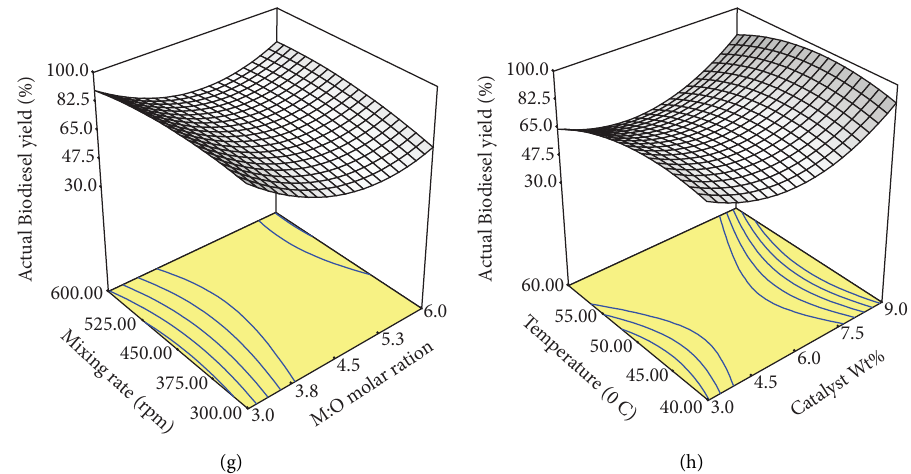
Figure 8: Te 2D contour and 3D RSM plots representing the interactive efects of the studied independent parameters on the trans- esterifcation